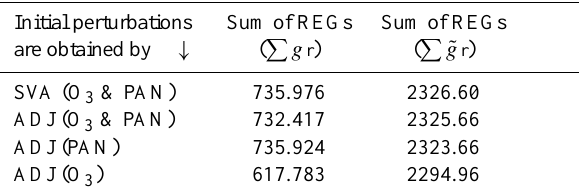
Table 10. Summarised error growths of scenario PLUME and UR- BAN. Considered are relative error growths (REGs) with respect to initial and emission uncertainties (emission uncertainties are de- noted with a tilde). The error growths are obtained by inserting per- turbation vectors of unit length resulting from singular vector anal- ysis (SVA) and adjoint sensitivity (ADJ). The chosen final projec- tions are denoted in brackets. Simulation intervals were chosen ac- cording to the temporal configuration of the TSVD, and the results of all simulations were summed